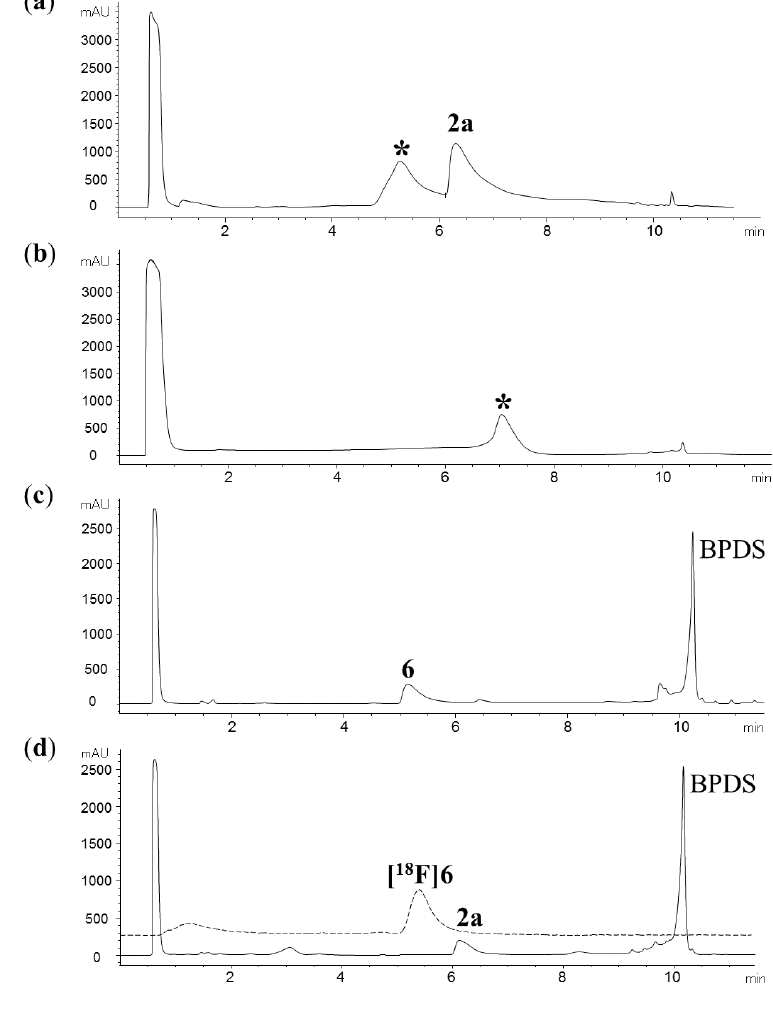
Figure 2. Analytical HPLC profiles (UV at 265 nm) of the reaction mixtures resulting from treatment of 2a with non-radioactive FEA (1 equiv.) in the presence of excess copper(II) sulfate and ( a ) sodium ascorbate or ( b ) ascorbic acid. Unknown side products are labeled with *; ( c ) Reaction of 2a and FEA in the presence of the BPDS-copper(I) catalytic system; ( d ) Addition of 2a , copper(II) sulfate, BPDS and ascorbate to a crude reaction mixture containing [ 18 F]FEA resulted in clean formation of the triazole [ 18 F] 6 (radioactivity profile shown as dotted